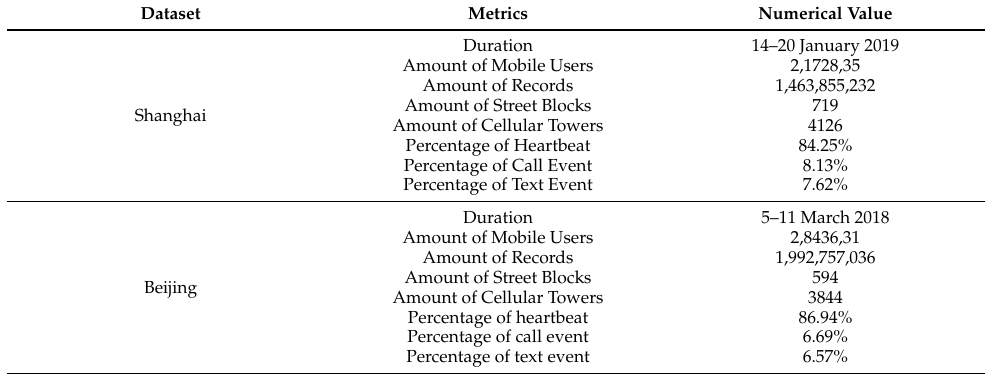
Table 1. Detailed information of cellular network datasets.